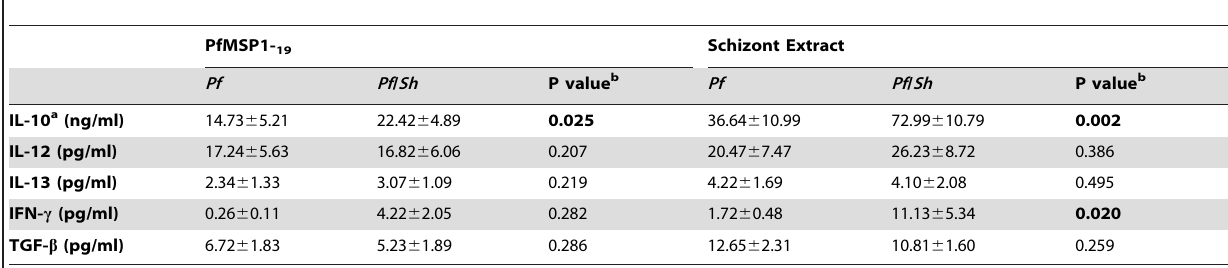
a : Results are mean 6 SEM of individual specific production (after subtracting the amount detected in unstimulated medium control cultures for each individual). b : P value between Pf and Pf/Sh groups (nonparametric Mann-Whitney U test ). Differences are considered significant for P , 0.05.